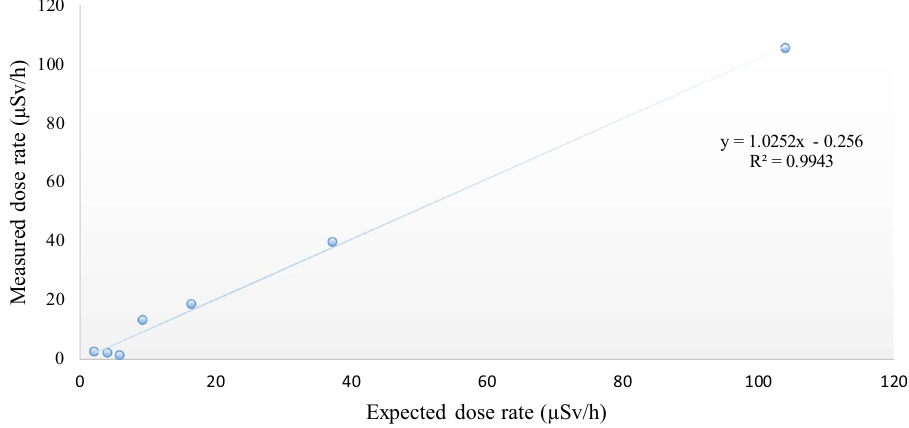
Figure 5. Measured and expected dose rates (µSv/h).